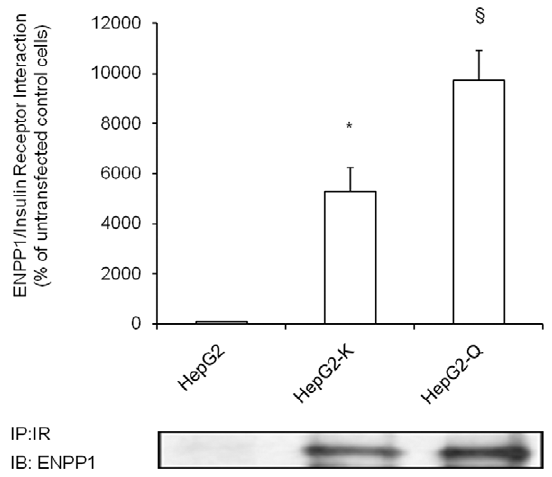
Figure 2. ENPP1/IR interaction. Lower panel: HepG2 cells were either transfected (lanes 2–3) or not (lane 1) with ENPP1 -K121 cDNA (lane 2) or with ENPP1 -Q121 cDNA (lane 3) and stimulated with insulin as described in methods. Total cell lysates were immunoprecipitated by using anti IR-alpha subunit antibody and ENPP1/IR interaction was evaluated by Western blot analysis with anti-ENPP1 specific antibody. Bars (upper panel) represent quantitative analysis of three independent Western blots (mean 6 SEM), while a representative experiment is shown in the lower panel. As compared to HepG2 control cells, the amount of ENPP1 associated with IR was greatly increased in HepG2-K (*p=0.002, second vs. first bars, n=3 experiments in separate times) and even more profoundly in HepG2-Q ( 1 p , 0.001, third vs. first bars, n=3 experiments in separate times) cells. When properly tested, a progressive increase of ENPP1/IR interaction was observed from control to HepG2-K and then HepG2-Q cells (p for trend , 0.001).